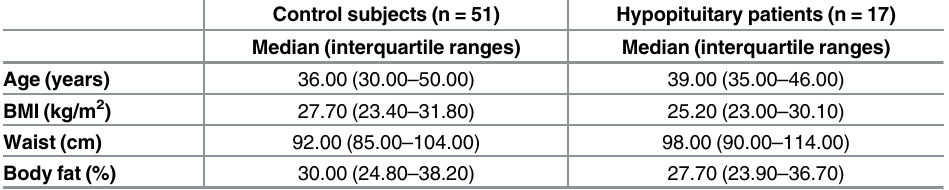
Table 1. Age, BMI, waist and total body fat (median, interquartile ranges) in hypopituitary patients and control